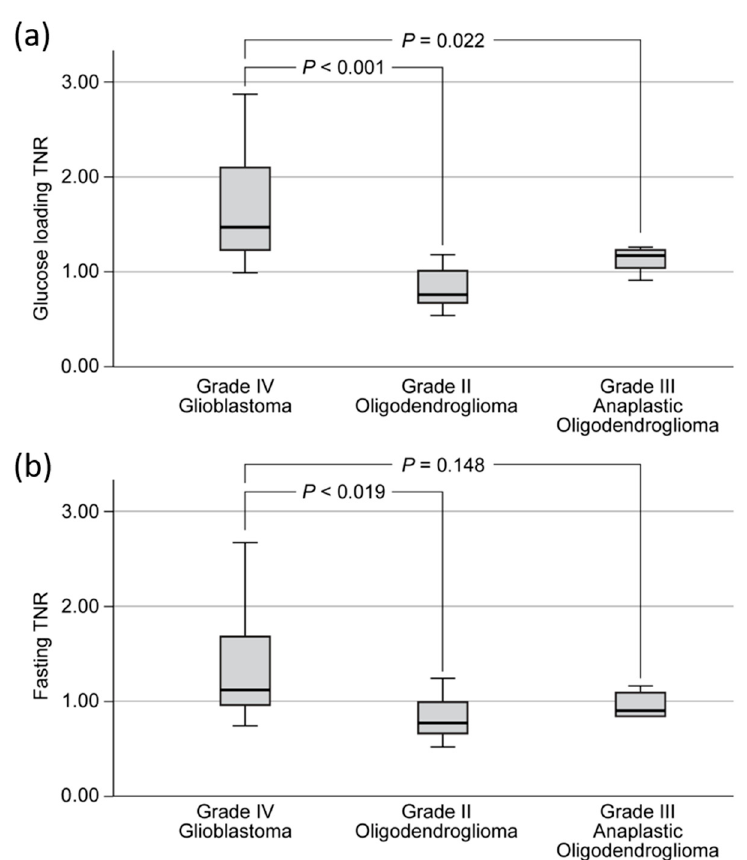
Figure 5. 18 F-FDG TNRs of grade II oligodendrogliomas, grade III anaplastic oligodendrogliomas, and grade IV IDH-wildtype glioblastomas in ( a ) glucose loading 18 F-FDG PET / CT and ( b ) fasting 18 F-FDG PET / CT.